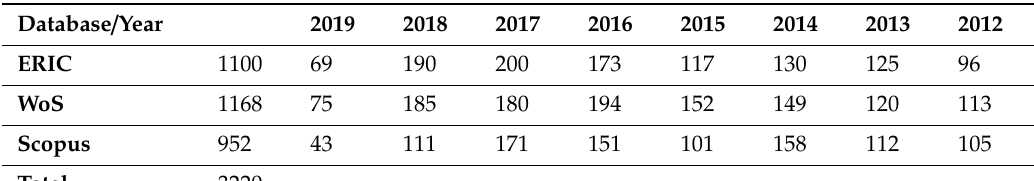
Table 2. Number of results in years and databases.